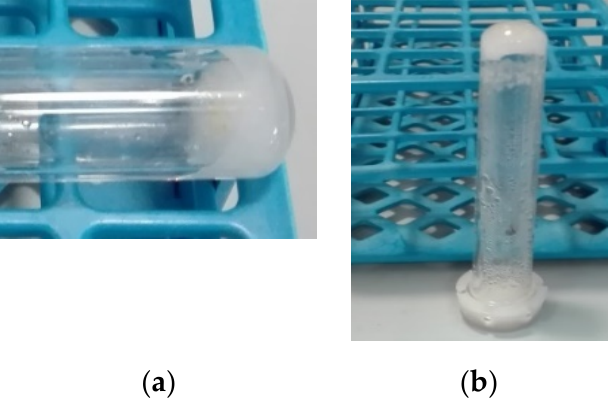
Figure 3. Pictures of hydrogels: ( a ) compound 1f; ( b ) compound 1g.